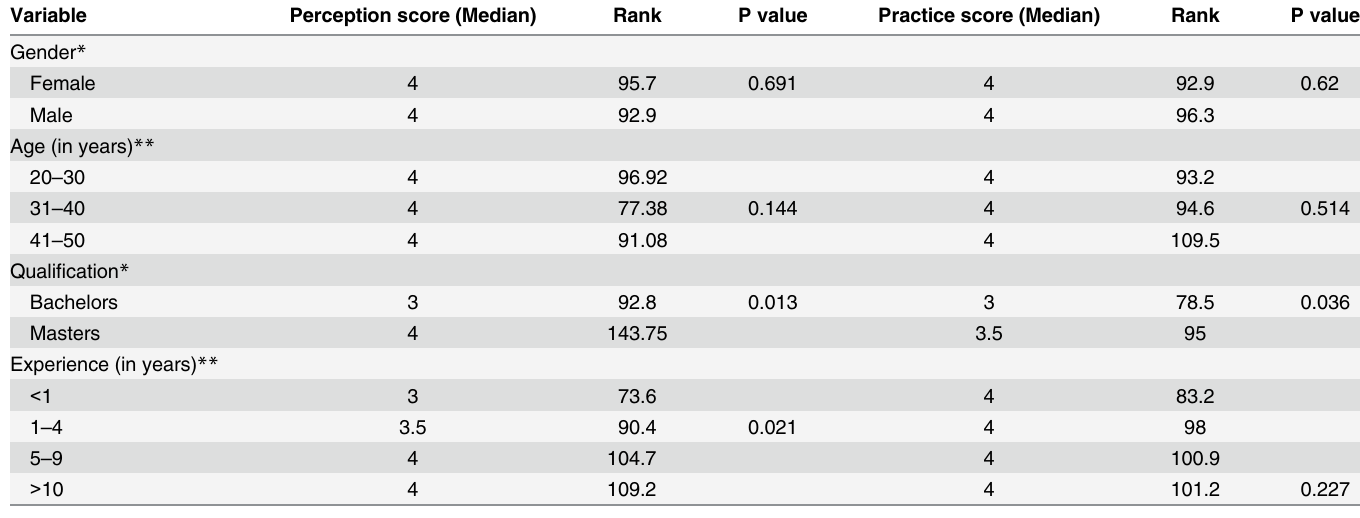
Table 4. Median scores of participants about their perception and experience of antimicrobial